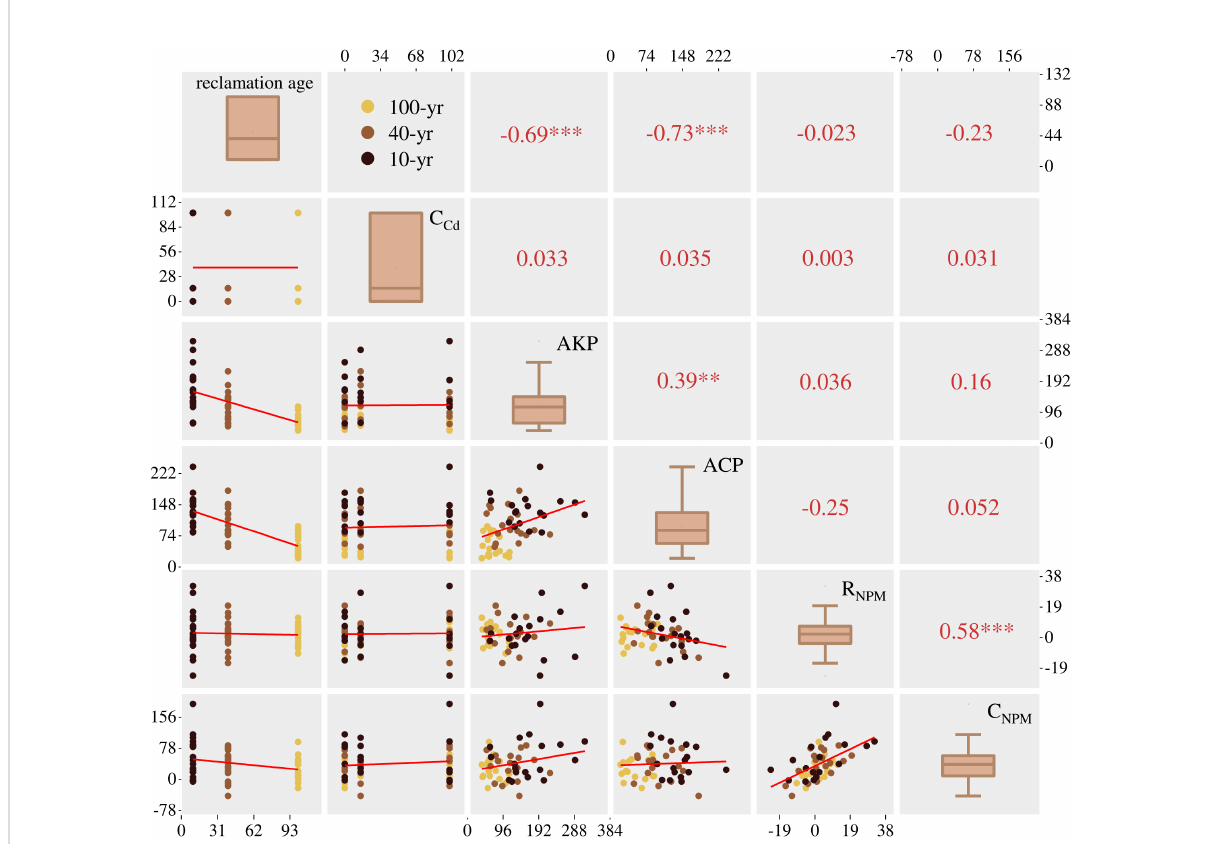
FIGURE 4 Spearman correlation analysis among Cd concentration, reclamation ages, ACP activity, ALP activity, C NPM and R NPM . Notes: C cd , Cd addition dose. ***Signi fi cant correlation at P < 0.001 level. **Signi fi cant correlation at P < 0.01